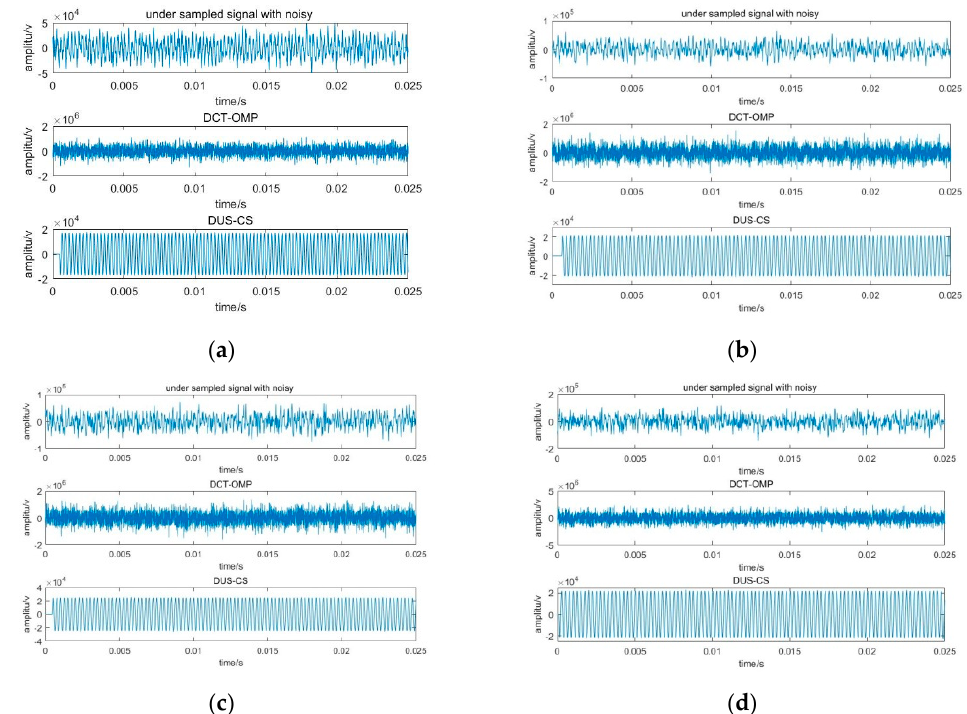
Figure 11. Reconstruction results with compression ratio of 20%. ( a ) SNR = 3 dB; ( b ) SNR = 0 dB; ( c ) SNR = − 3 dB; ( d ) SNR = − 8 dB. Figure 12 is a compressive sensing signal with a compression ratio of 10% with different SNRs.